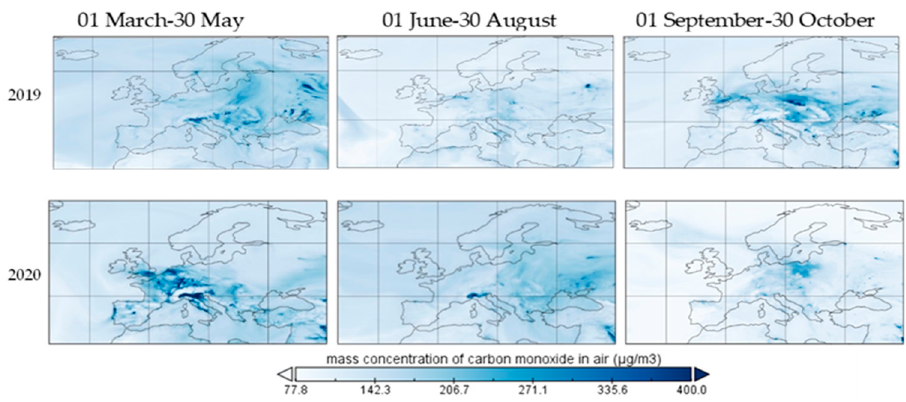
Figure 10. Carbon monoxide over Europe during restriction period, 2019 and 2020.